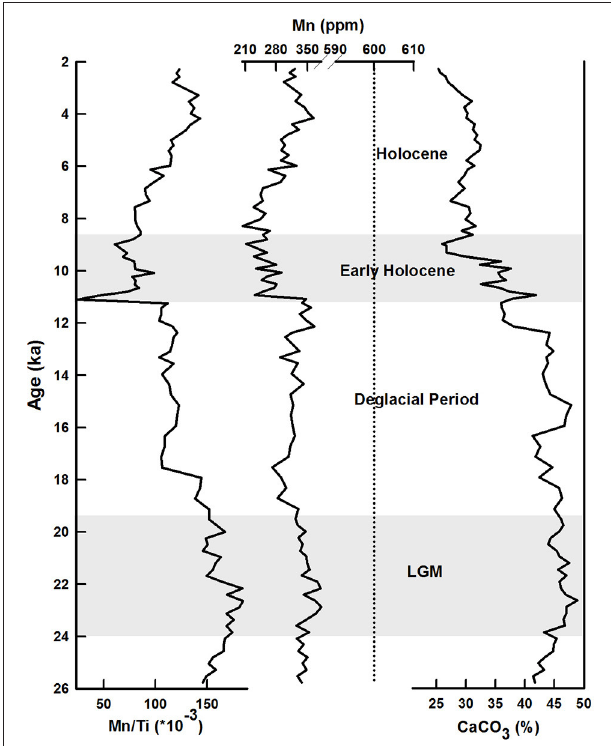
FIGURE 4 | Downcore variation of Mn, CaCO 3, and Mn/Ti indicates that Mn forms authegenic carbonate in presence of CaCO